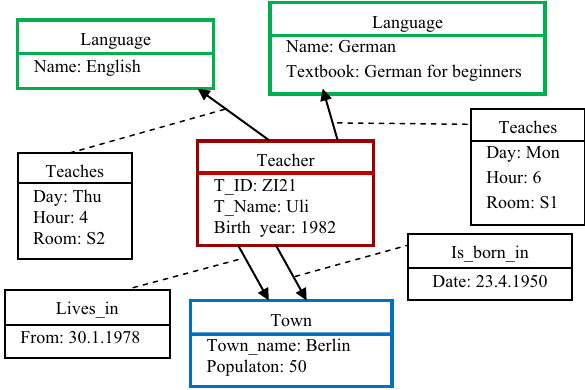
Fig. 1 Example of a GDB